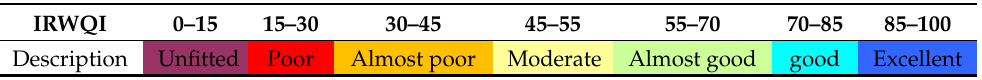
Table 3. Color bar specifying ranges of IRWQI for different water quality classes of Management IWR [42] standard, reflecting quality of a surface/underground water